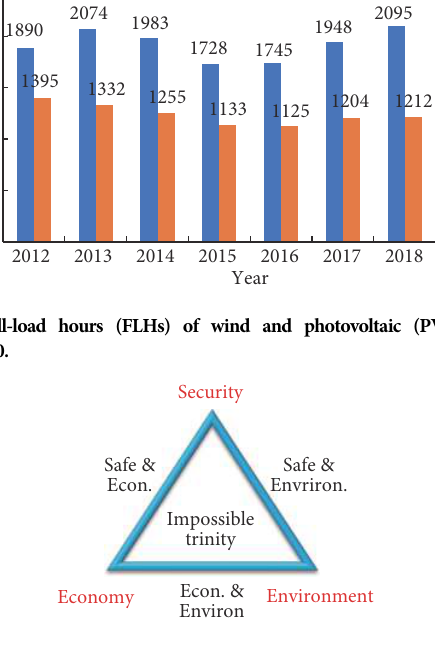
Fig. 6 Impossible trinity of a power